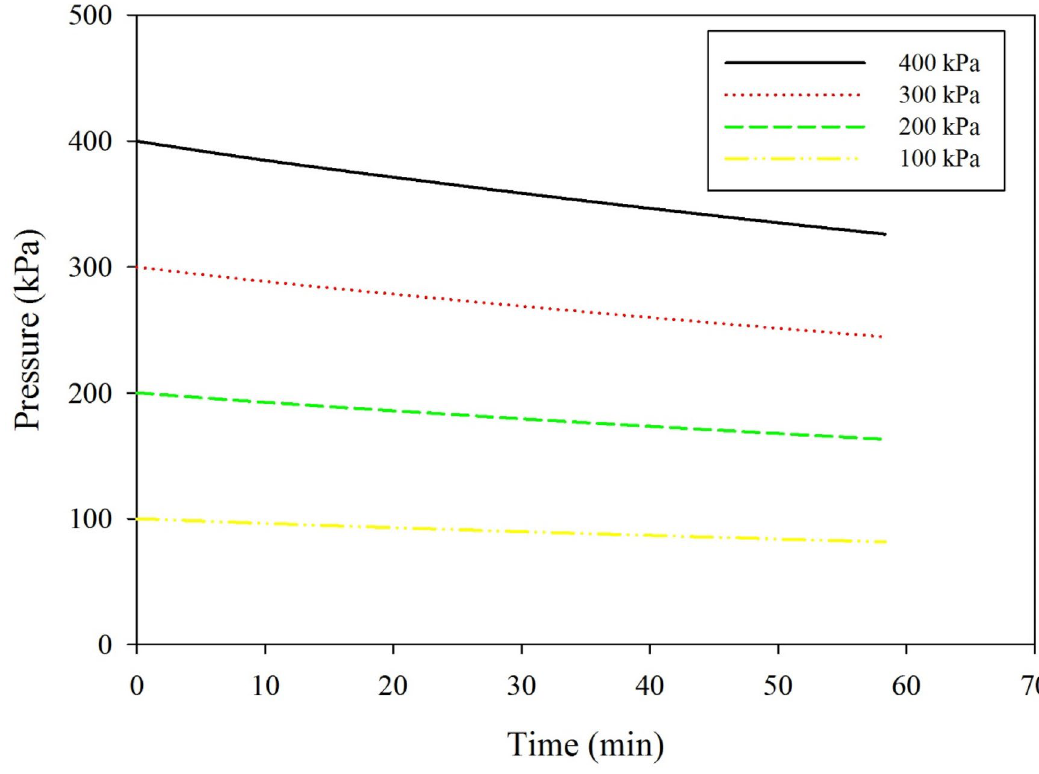
Figure 6. Effect of CO 2 initial gas pressure versus time on the pressure drop rate under no mixing conditions; temperature is 25 °C, nanoparticle diameter is 10 nm, with 0.1 wt% TiO 2 solids